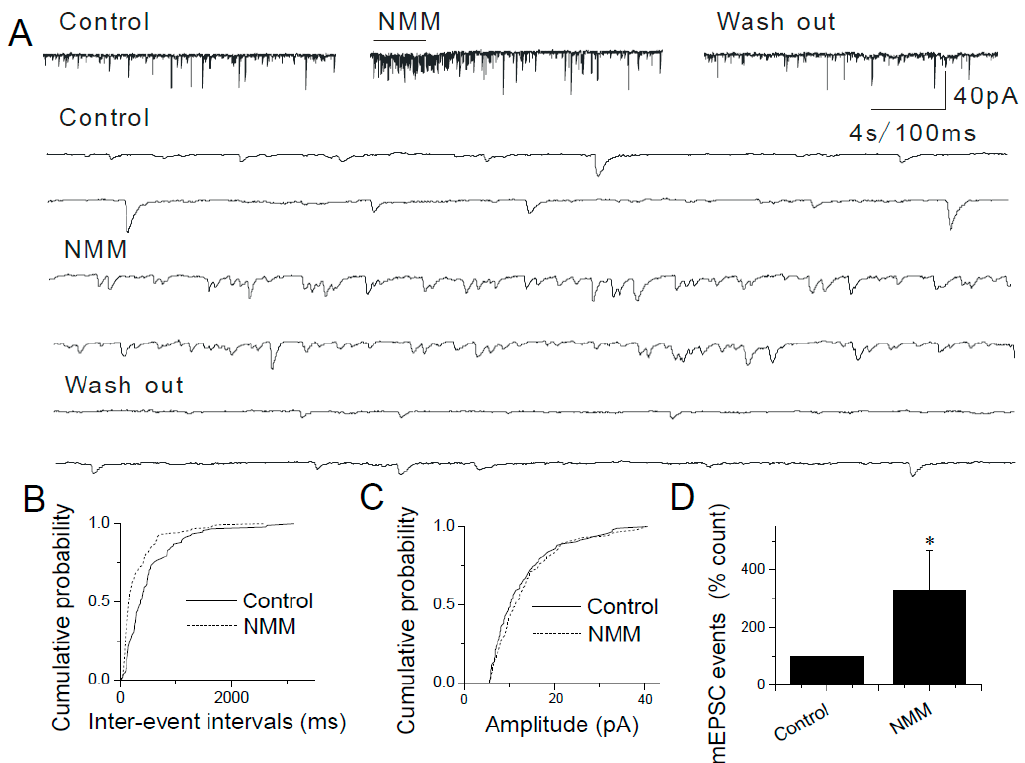
Figure 3. Modulation of synaptic transmission in the NTS by N-methylmaleimide (NMM). ( A ) Application of NMM (100 µ M) increases the frequency of mEPSCs in a reversible manner. The synaptic events are shown in higher time resolution below. ( B ) Cumulative probability plot showing decreased inter-event intervals representing increased frequency of mEPSCs ( p < 0.0001, KS test). ( C ) The increase in frequency is not accompanied by a change in the amplitude. ( D ) Summary graphs showing that the NMM-mediated increase in mEPSCs ( n = 8, * p < 0.05). The asterisk (*) represents p < 0.05 as compared to